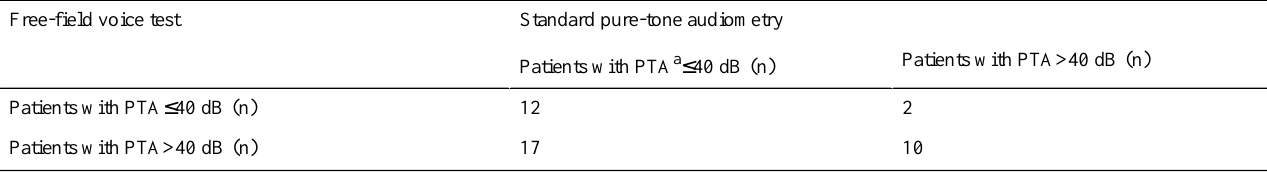
Table 4. Accuracy of free-field voice test as a screening test compared to the standard pure-tone audiometry